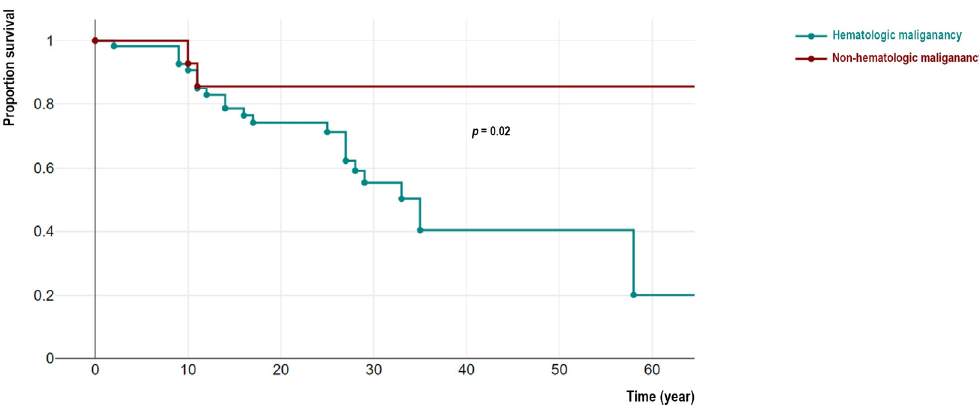
Figure 2. Comparison of survival analysis of cohort of IEI patients with hematologic and non-hematologic malignancies.